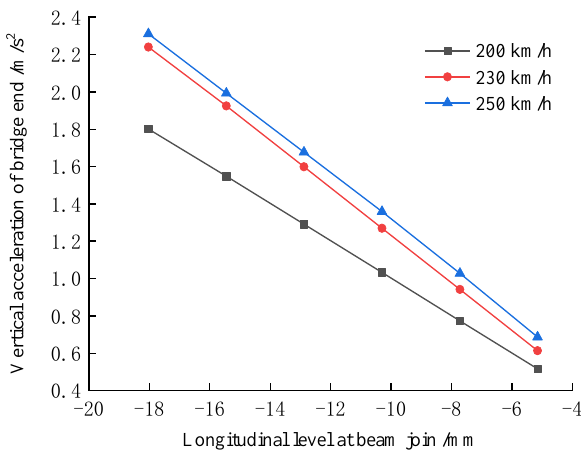
Figure 25. Vertical acceleration of bridge end.